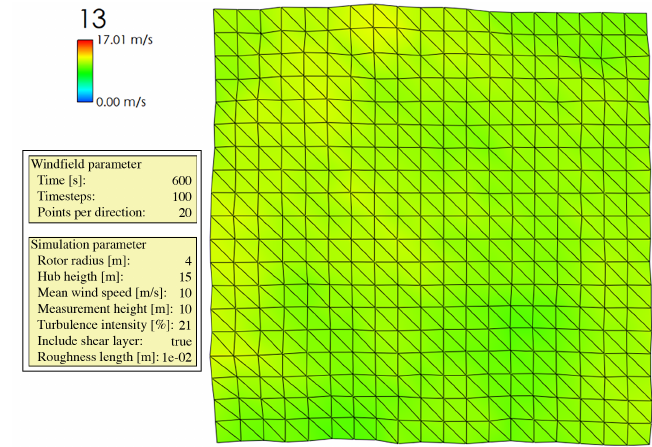
(cid:0) (cid:1) 10 m with high turbulence s